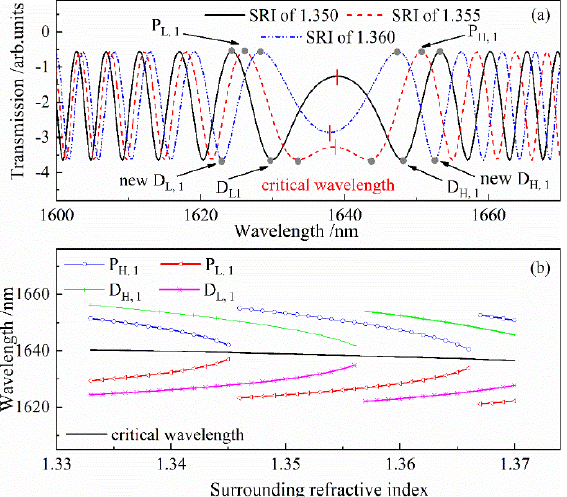
Figure 10. The simulated results of the etched SFS structure ( 𝑑 𝐹𝑀𝐹 = 21.3 μm, 𝐿 𝐹𝑀𝐹 = 20 cm): ( a ) the transmission spectra under the SRIs of 1.350, 1.355, and 1.360; ( b ) wavelength shifts in the critical wavelength and interference peaks/dips on each side of the critical wavelength.